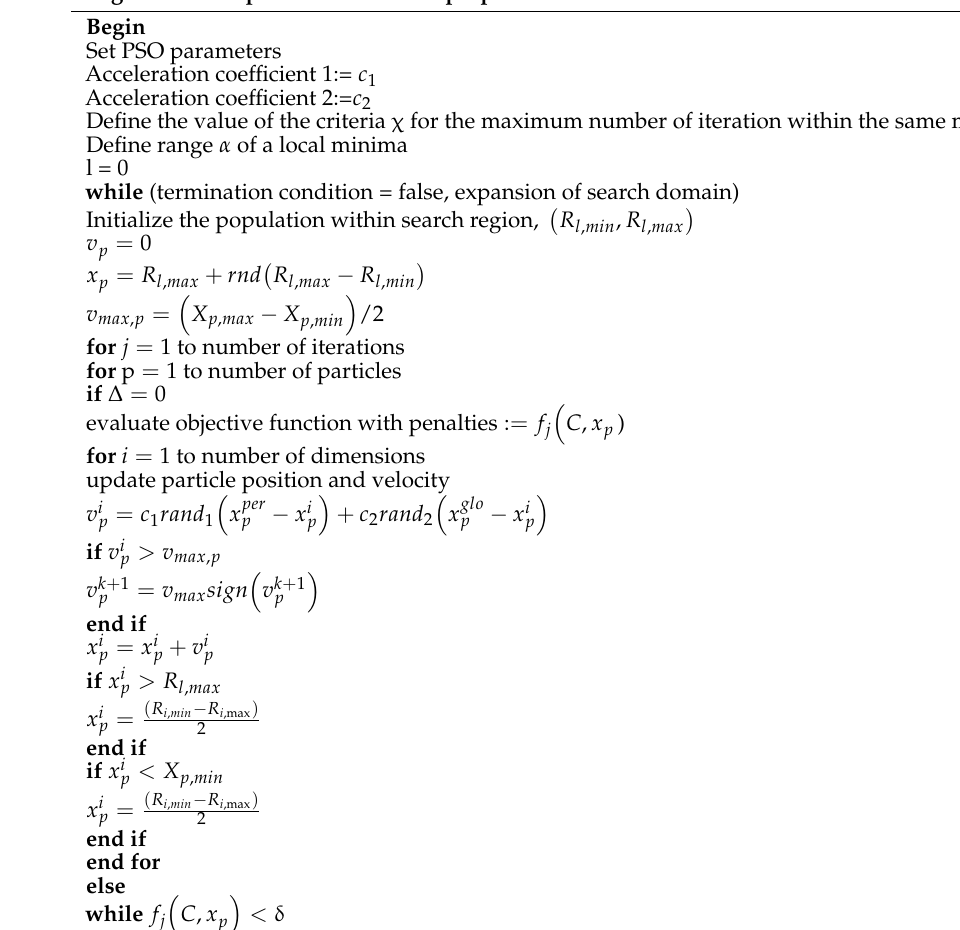
Algorithm 1. A pseudo-code of the proposed